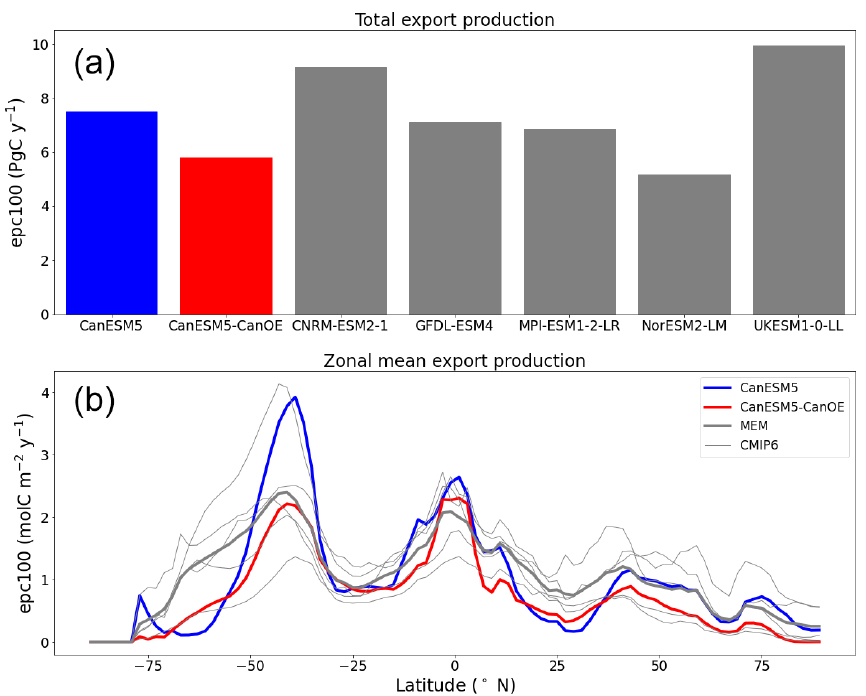
Figure 19. (a) Global total export production (epc100) in PgCyr − 1 (b) and zonal mean export production in molCm − 2 yr − 1 according to selected CMIP6 models (mean for 1985–2014 of historical experiment). The thick red line represents CanESM5-CanOE, thick blue line CanESM5, thin grey lines individual CMIP6 models, and thick grey line the model ensemble mean (excluding CanESM5 and CanESM5-